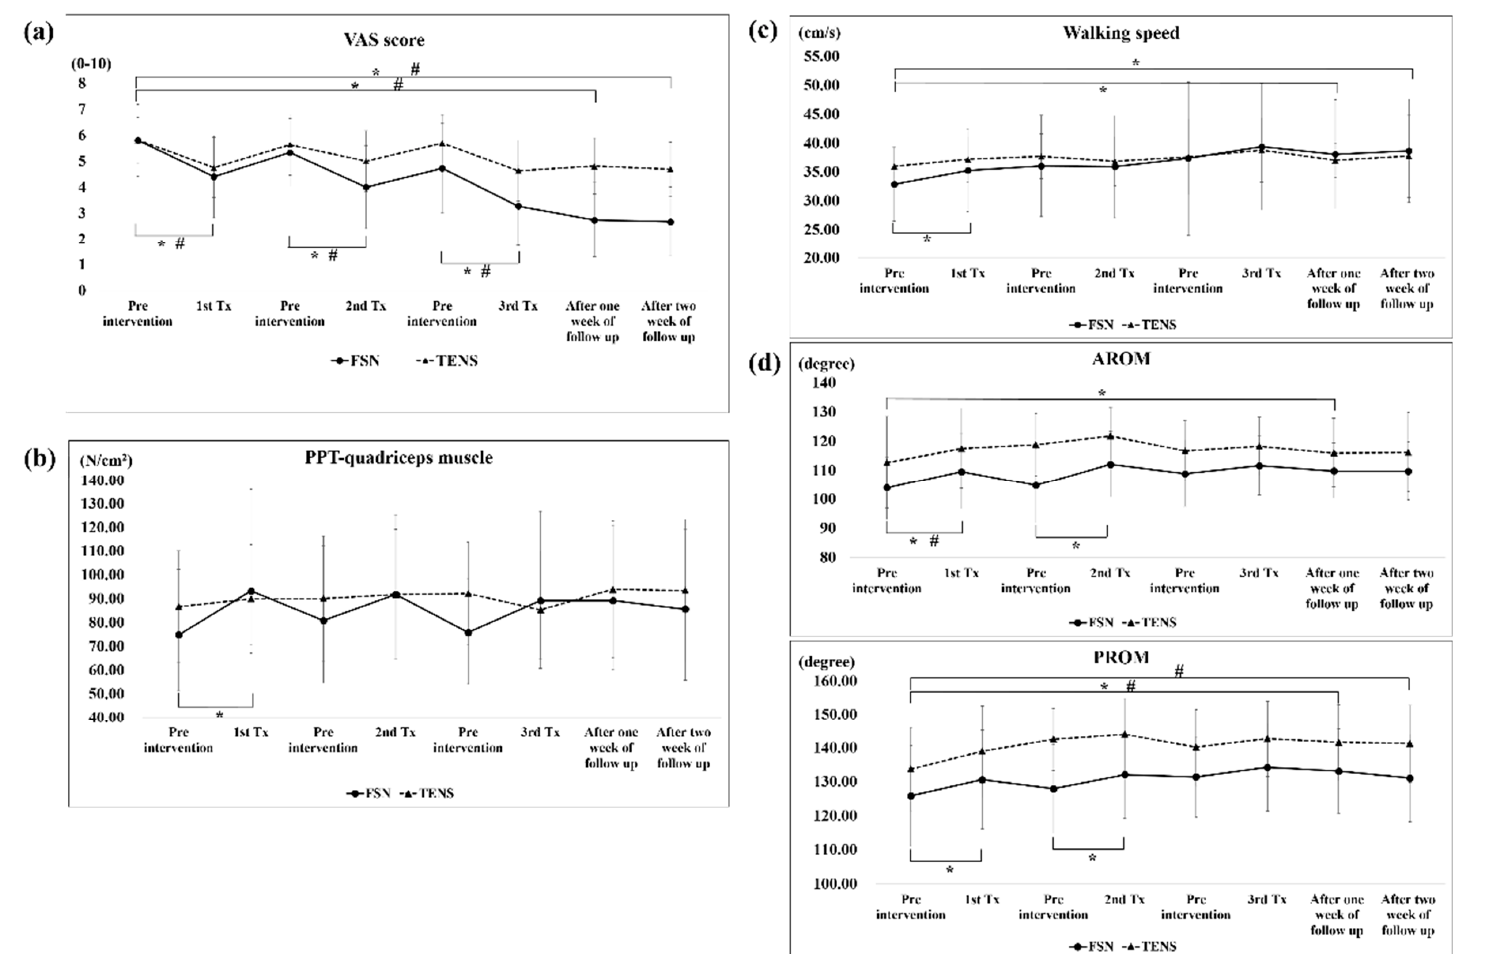
Figure 5. Comparison of the VAS, PPT of the quadriceps muscle, walking speed, and ROM between the two groups after each treatment. The pre- and post-treatment values of the VAS ( a ), PPT-quadriceps muscle ( b ), walking speed ( c ), and ROM ( d ) were measured in 3 treatment sessions in both groups and followed up after one week and two weeks in both groups. * represents the FSN group p < 0.05; # represents the TENS group p < 0.05. VAS: visual analog scale; PPT: pressure pain threshold; AROM: active range of motion; PROM: passive range of motion; FSN: Fu’s subcutaneous needling; TENS: transcutaneous electrical nerve